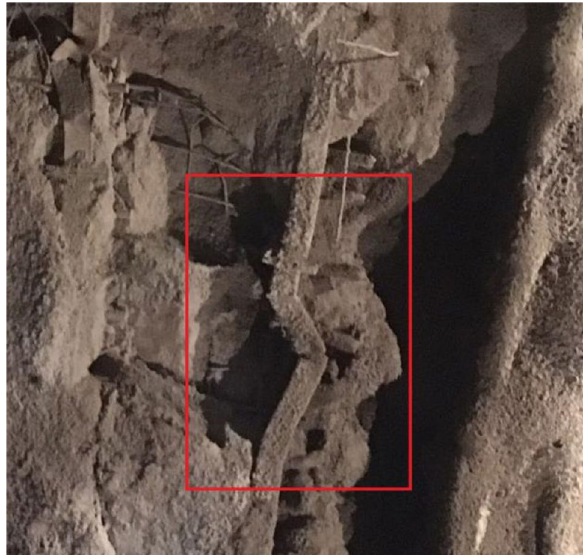
Figure 7. The failure of the steel arch frame at DK80 + 427.